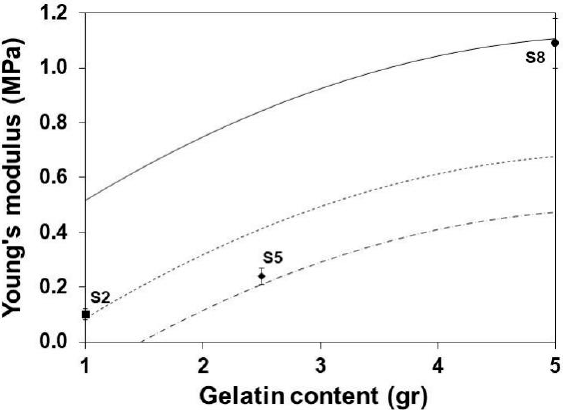
Figure 5. Effect of gelatin content on the YM of SLGMs, varying the glycerol content: 1.0 mL (con ‐ tinuous), 2.5 mL (dashed) and 5.0 mL (dotted). Experimental points: S2, S5 and S8. Conditions: water content = 50 mL; maturation time = 7.5 min.